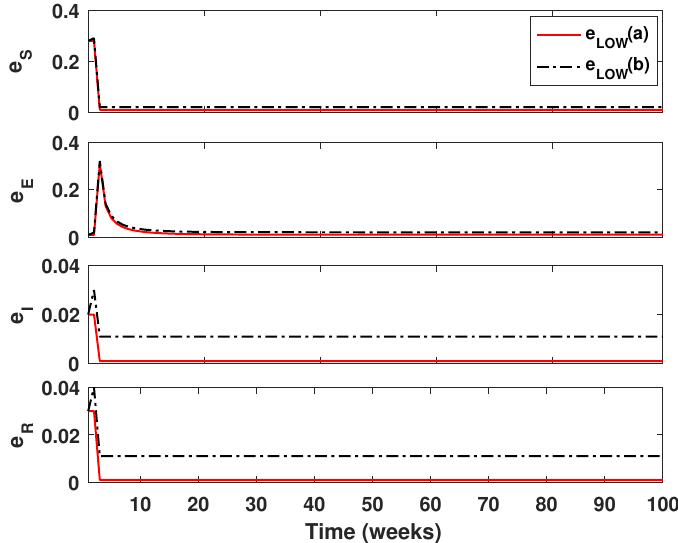
Figure 8. Lower-bound error: (a) proposed method; (b) method given in